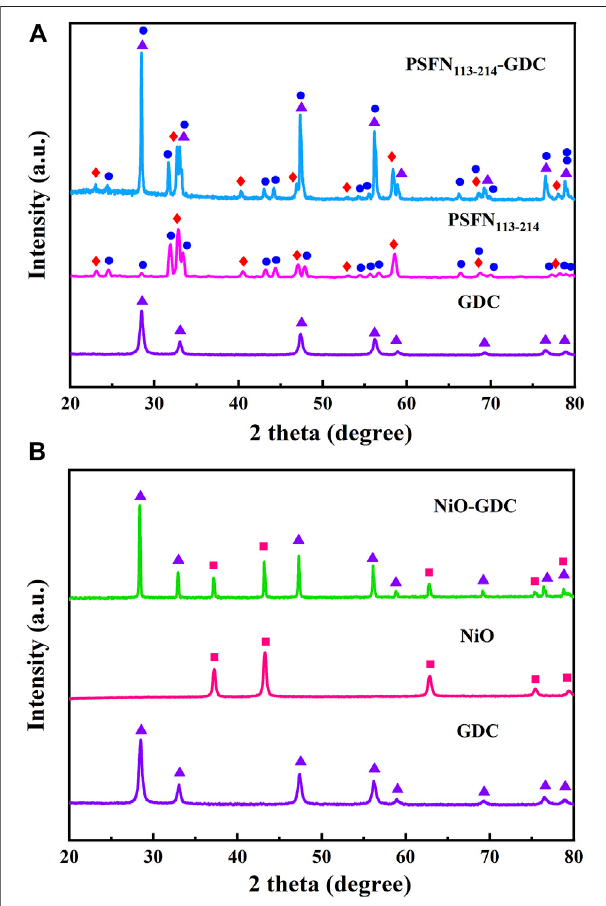
FIGURE 2 | After calcination at 1000 ° C for 10 h, (A) XRD patterns of PSFN 113-214 and GDC mixed in equal proportions and (B) XRD patterns of NiO and GDC mixed in equal proportions.